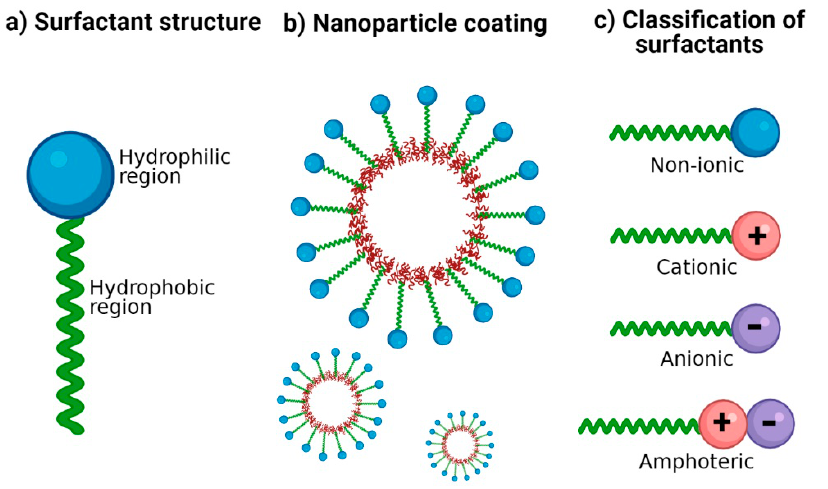
Figure 1. Surfactants for nanoparticle stabilization. ( a ) Classic structure of surfactants: its amphiphilic nature is represented with a hydrophilic region and a hydrophobic region. ( b ) Coating of NP with surfactants: the hydrophobic region possesses an affinity for the nanoparticle surface and the hydrophilic region with an affinity for the aqueous dispersion medium. ( c ) Classification of surfactants according to the ionic charge in its polar group: no charge (non-ionic), positive charge (cationic), negative charge (anionic), and both positive and negative charge (amphoteric).